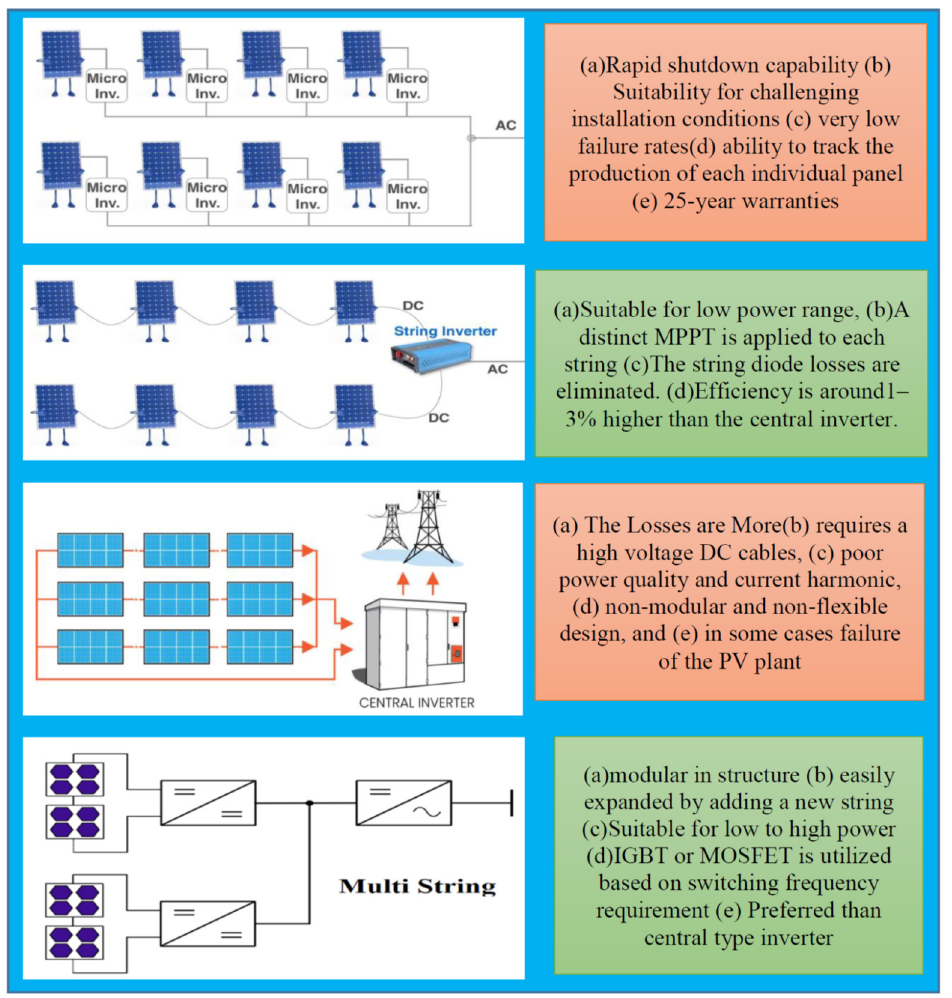
Figure 4. Comparison of PV inverter.